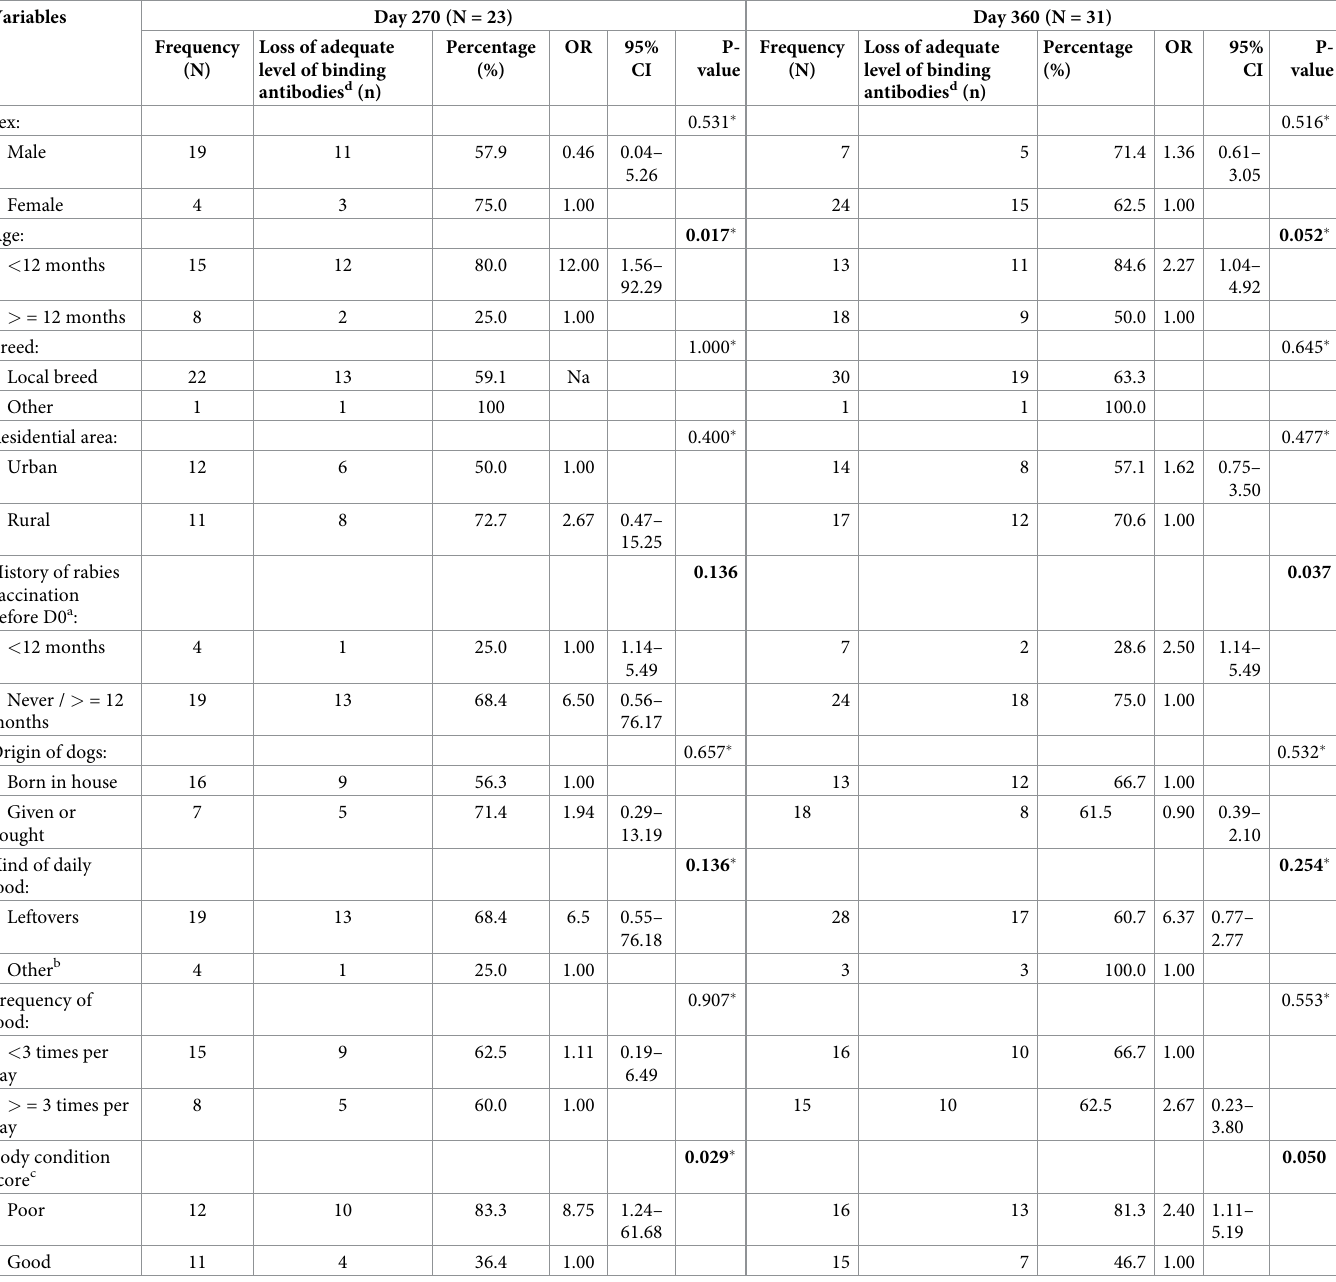
Table 3. Frequency (n) and percentage (n/N) of dogs losing adequate level binding antibodies 270 (D270) and 360 (D360) days after vaccination, stratified by differ- ent demographic characteristics of the dogs. The influence of demographic parameters were explored by univariable logistic regression